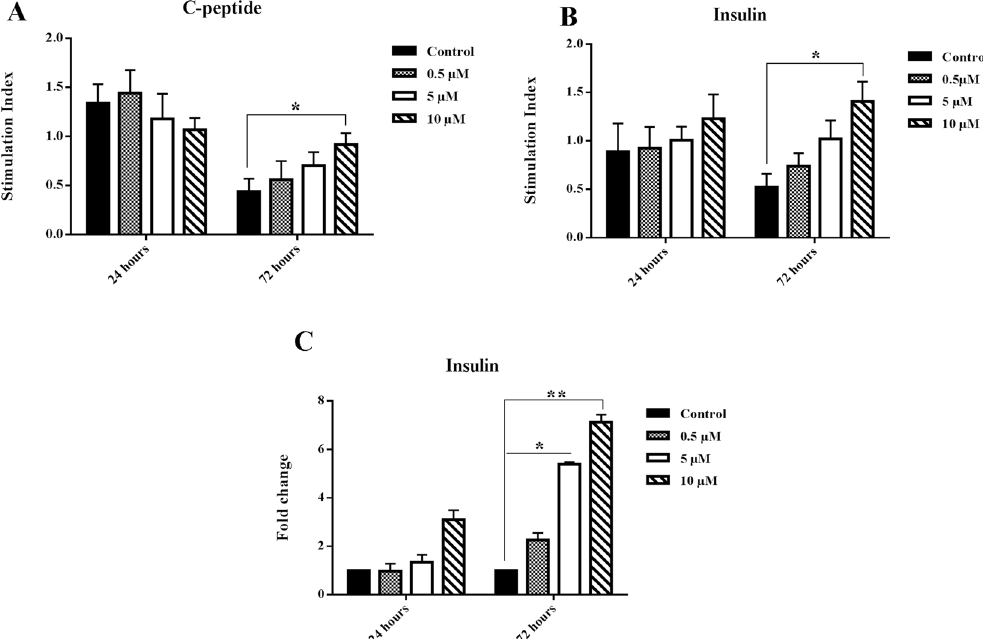
Figure 5. Glucose stimulation C-peptide and insulin indexes and insulin gene expression. ( A ) C-peptide and ( B ) insulin stimulation indexes and ( C ) insulin mRNA expression in different concentrations of nobiletin. The experiment was done in triplicate from four donors and data were analyzed by Kruskal-Wallis and Post-hoc tests. Results were represented as mean ± SD. * p < 0.05 and ** p < 0.01.